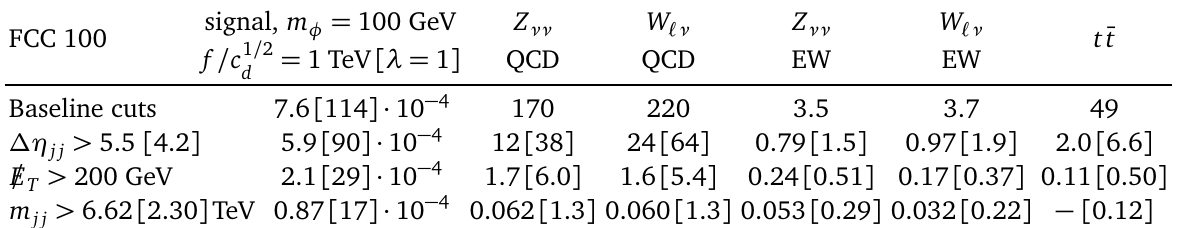
Table 6: Cross sections in pb. The baseline cuts are in Eq. (18), except that | η For 30 ab − 1 we have S = 1.0 [ 5.2 ] for the derivative [ marginal ] portal. A dash in- dicates that our MC statistics is insufficient to estimate the cross section. No EFT consistency condition is